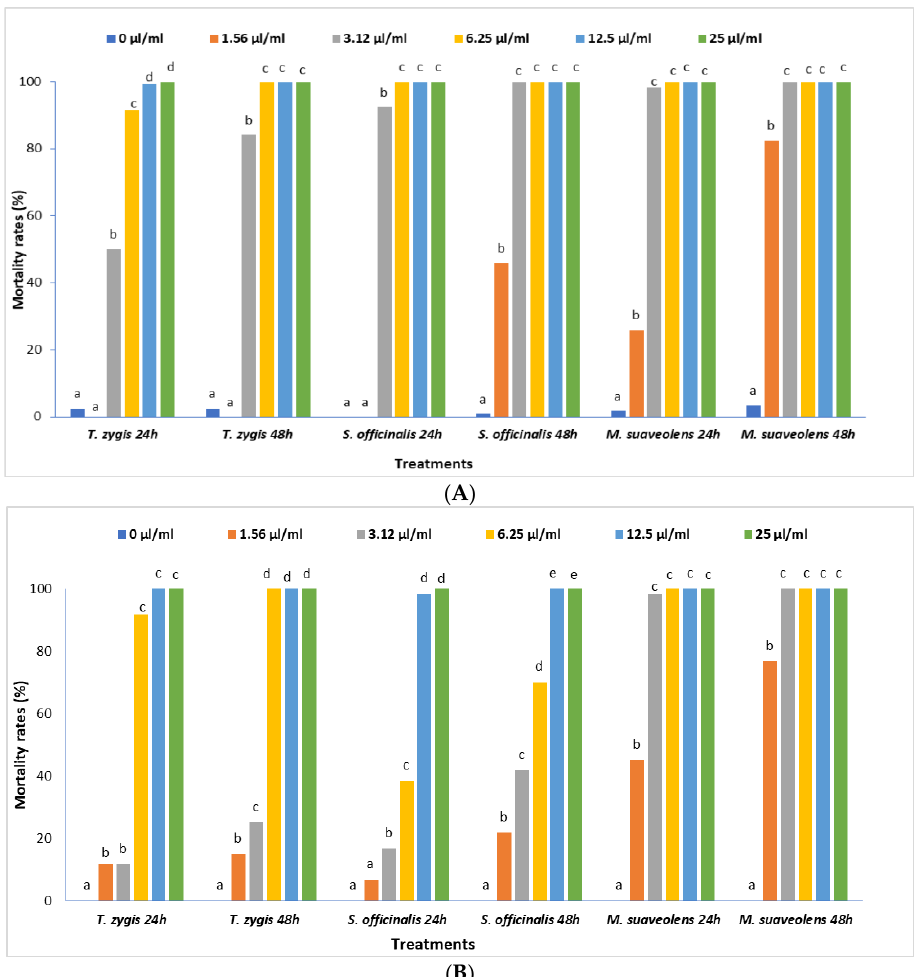
Figure 3. Response of C. capitata adults ( A ) and T. absoluta larvae ( B ) to different concentrations of the tested EOs. By treatment, the rates followed by the same letters were not statistically different at p < 5% according to the Newman – Keuls test.